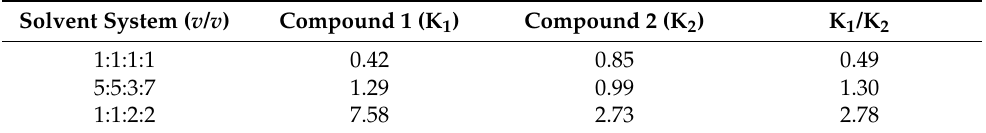
Table 3. K values of Inonotus obliquus in different two-phase solvent systems composed of n -hexane-ethyl acetate-MeOH-water.